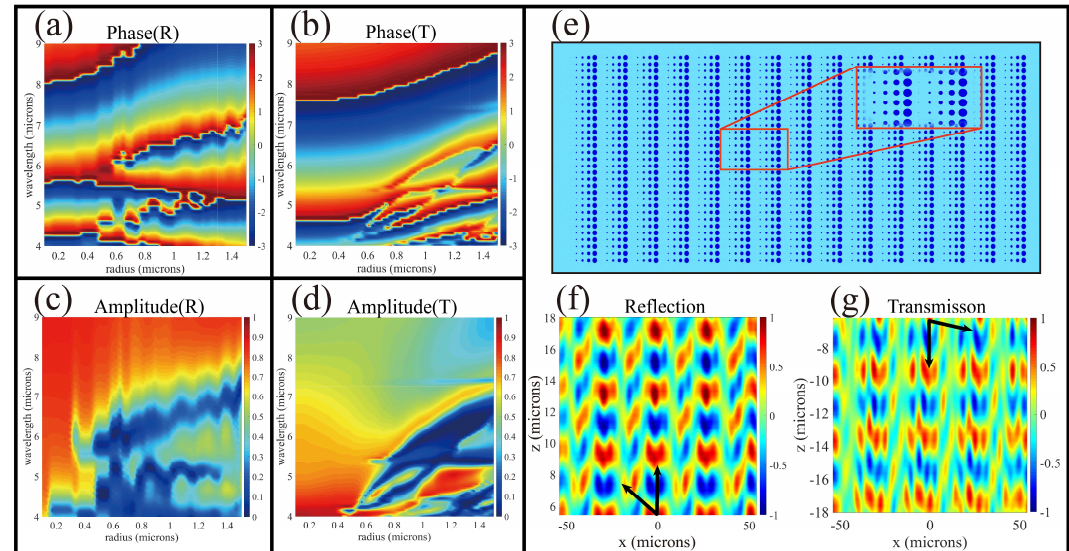
Figure 4. ( a ) Reflection and ( c ) transmission phase response of antennas with varying cylinder radius from 0.1 µ M to 1.5 µ M for di ff erent incidence wavelength from 4 µ M to 9 µ M. ( b ) Reflection and ( d ) transmission amplitude response of the same antennas. ( e ) The diagram of array structural of beam deflection metasurface; ( f , g ) are the electric field (real (Ex)) of reflective and transmissive deflection in the xz -plane,